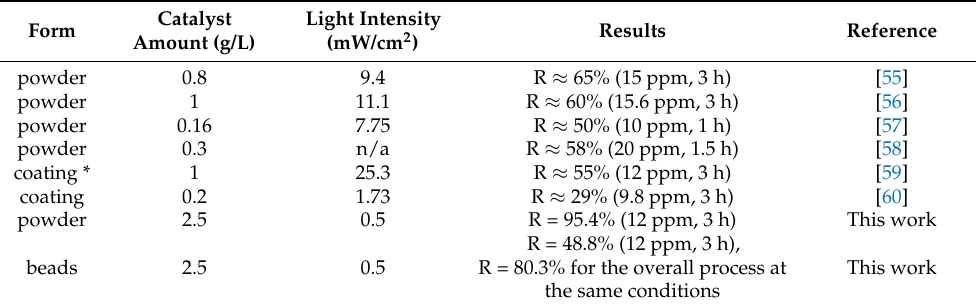
Table 4. Photocatalytic performance of Degussa P25 TiO 2 -based photocatalysts. Catalyst Light Intensity Form Amount (g/L) (mW/cm 2 )